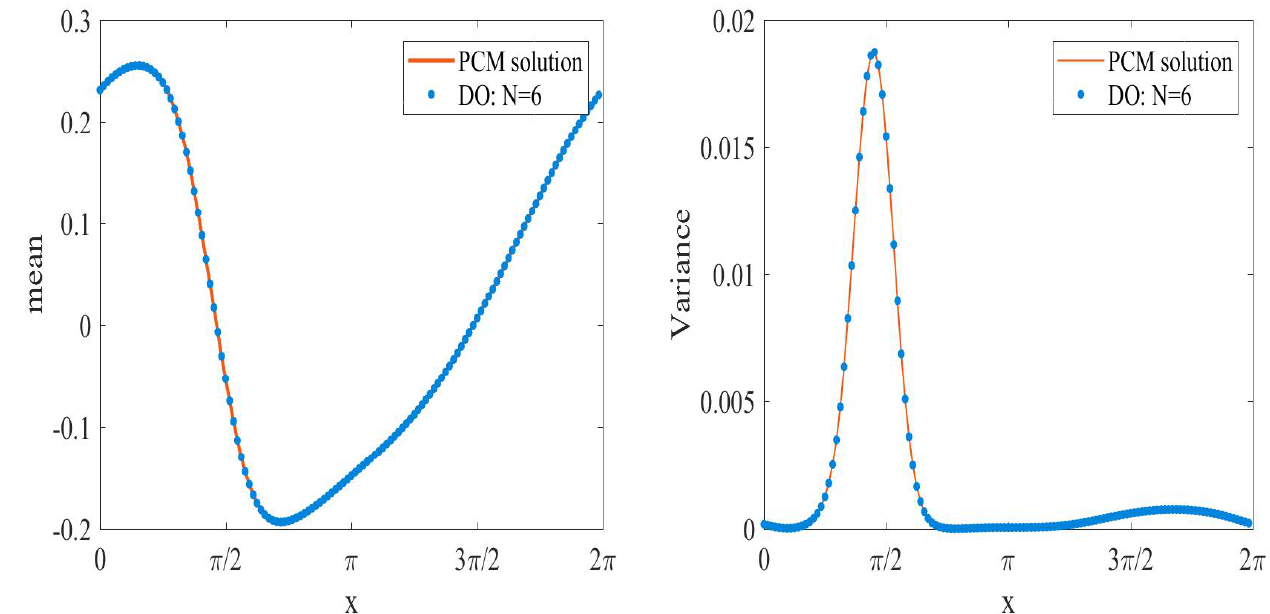
Figure 1. The mean ( left ) and variance ( right ) at t f =5 , with the switching time t s =1 and the number of modes N =6 . The reference solution is RK4 from the PCM method.